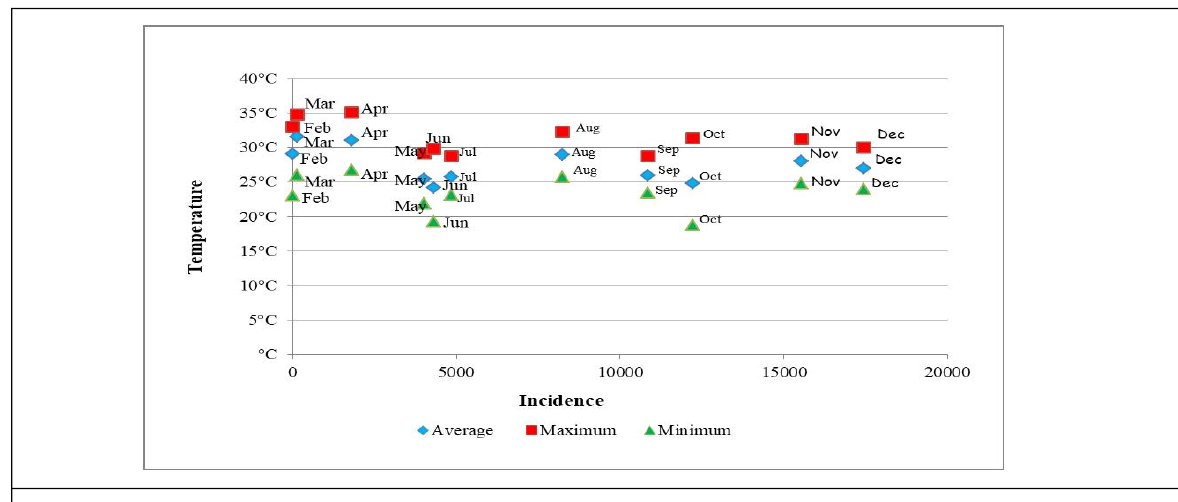
Figure 2: Average monthly temperature variables (average, minimum and maximum) from